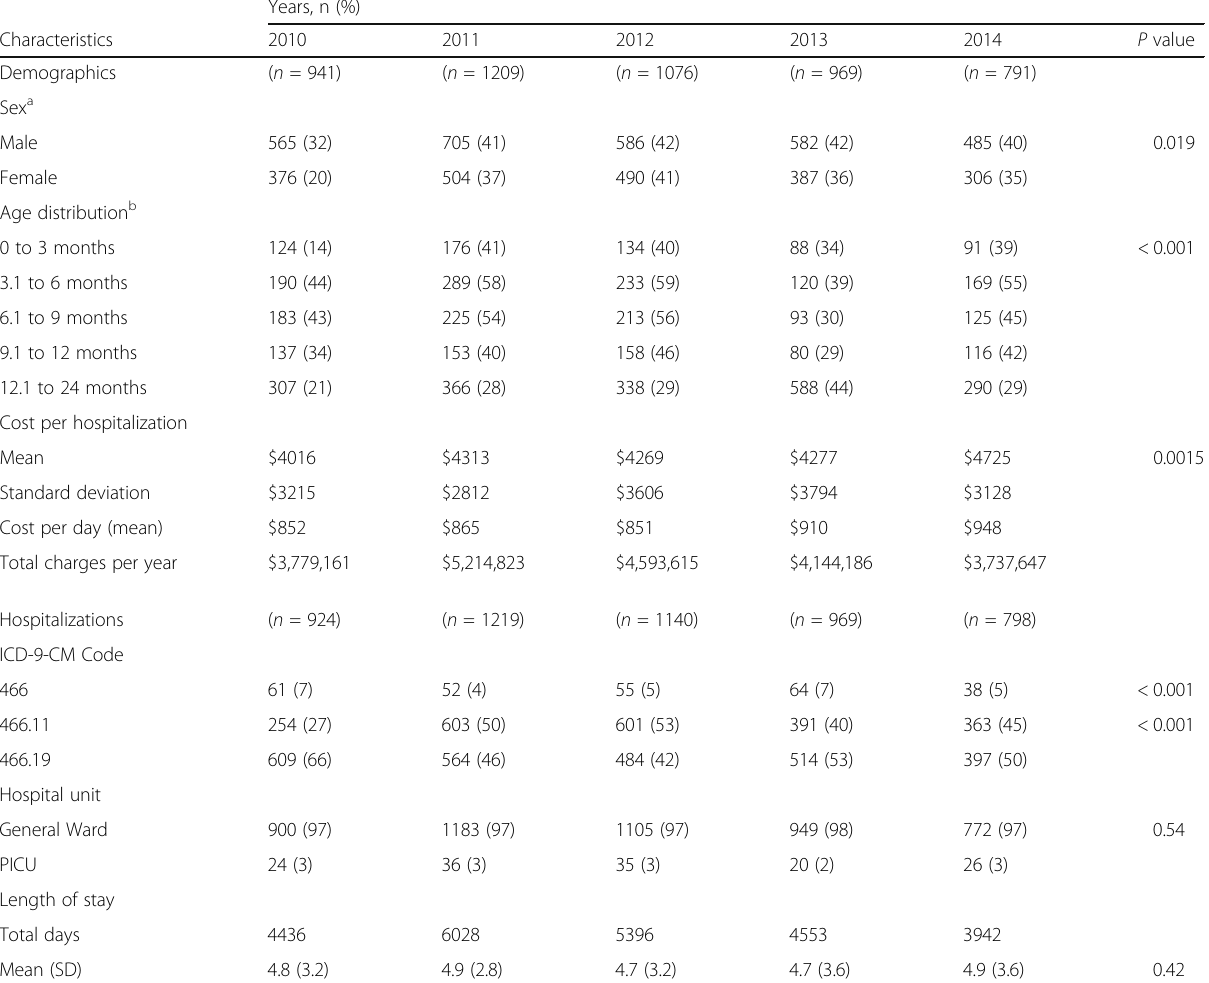
Table 2 Demographics and characteristics of bronchiolitis hospitalizations, 2010 – 2014 Years, n (%)